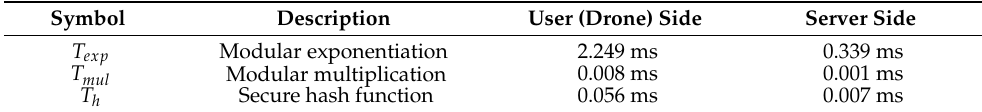
Table 2. Execution time of the various cryptographic operations.